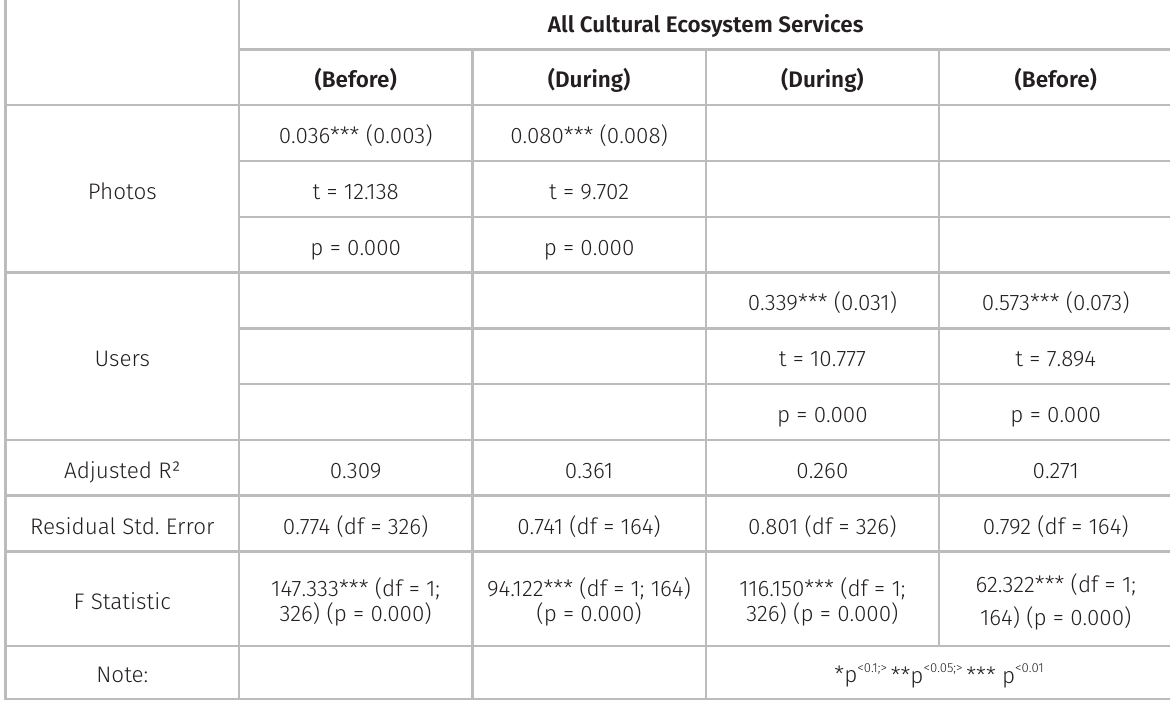
Table III. ANCOVA carried out to verify differences on the cultural services assigned to users and their photos between the periods before and during the oil spill